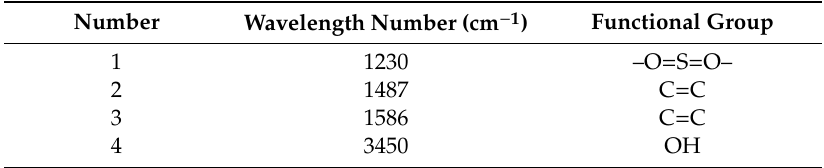
Figure 5. FTIR spectra of phosphorene and SPEEK: Polysulfone (PSf) membranes over the region 400–4000 cm − 1. Table 1. Assignment of FTIR bands at different wavelengths .